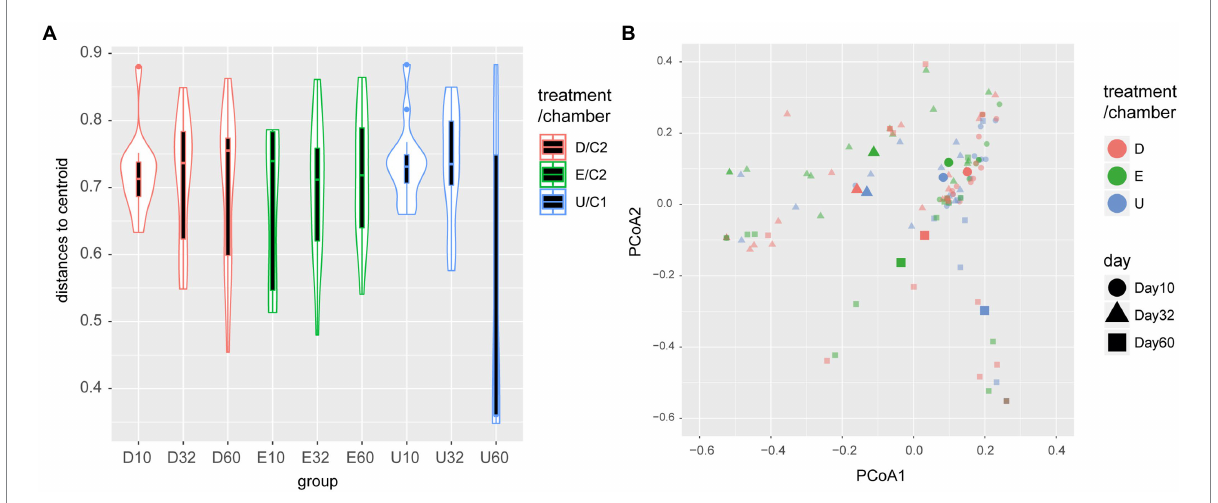
FIGURE 2 Community composition depending on plant initial conditions and time. (A) Divergence of community composition between plant individuals within each plant initial condition. Only for undamaged plants (chamber C1), there was a significant difference between days. In addition, on day 60, the divergence of composition in chamber C1 was smaller than in Chamber C2 (PERMDISP, p = 0.0092) (B) PCoA ordination and plant initial conditions (undamaged, damaged, or exposed) and sampling day (10, 32, or 60). The points with large marks (circle, triangle, and rectangle) are the spatial medians, which are representative of the community composition of each plant initial condition at each sampling day. Small marks represent each plant